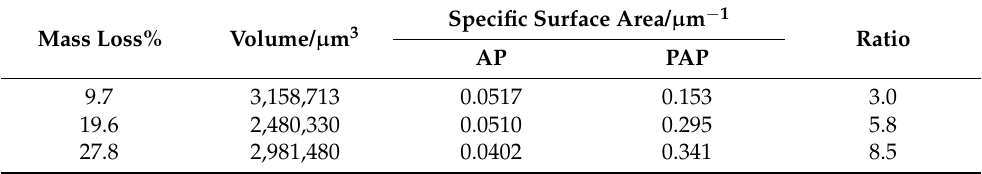
Table 2. Specific surface areas of porous